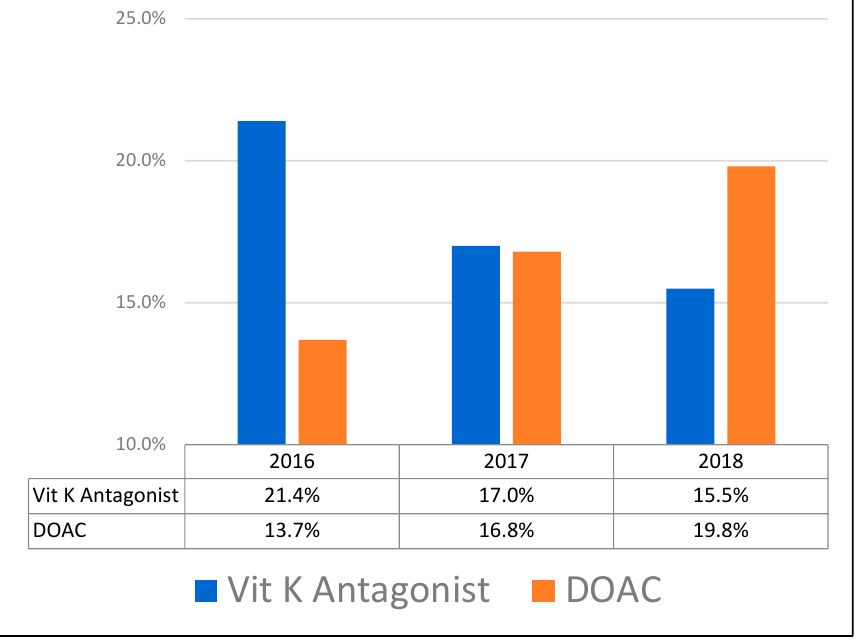
Figure 1. Comparison of the prevalence of Vitamin K Antagonist and DOAC treatment at admission over the study period 2016–2018 (percentage of all anticoagulated patients).